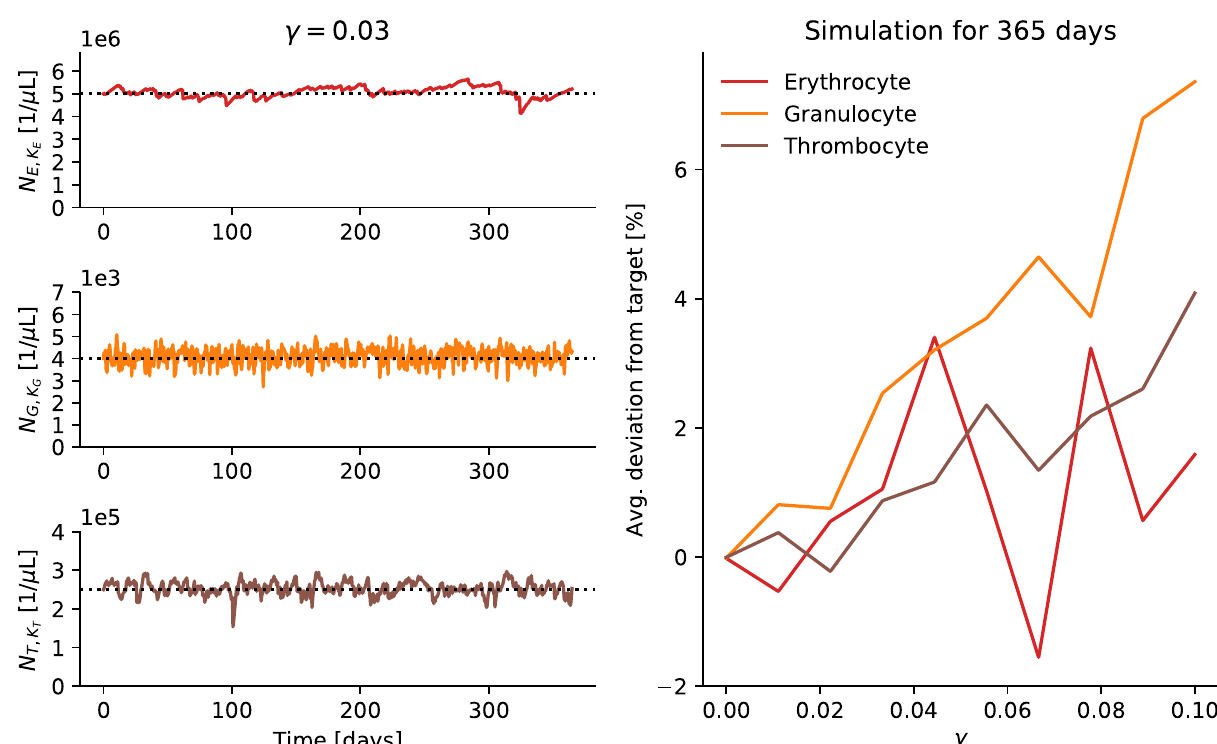
Fig 5. Deviation from target values. The panels on the left show the erythrocyte ( N hematopoietic system in steady state. The noise scaling parameter γ is varied in the panel on the right and the resulting average deviation of the counts from their target values is shown for one year-long run of the